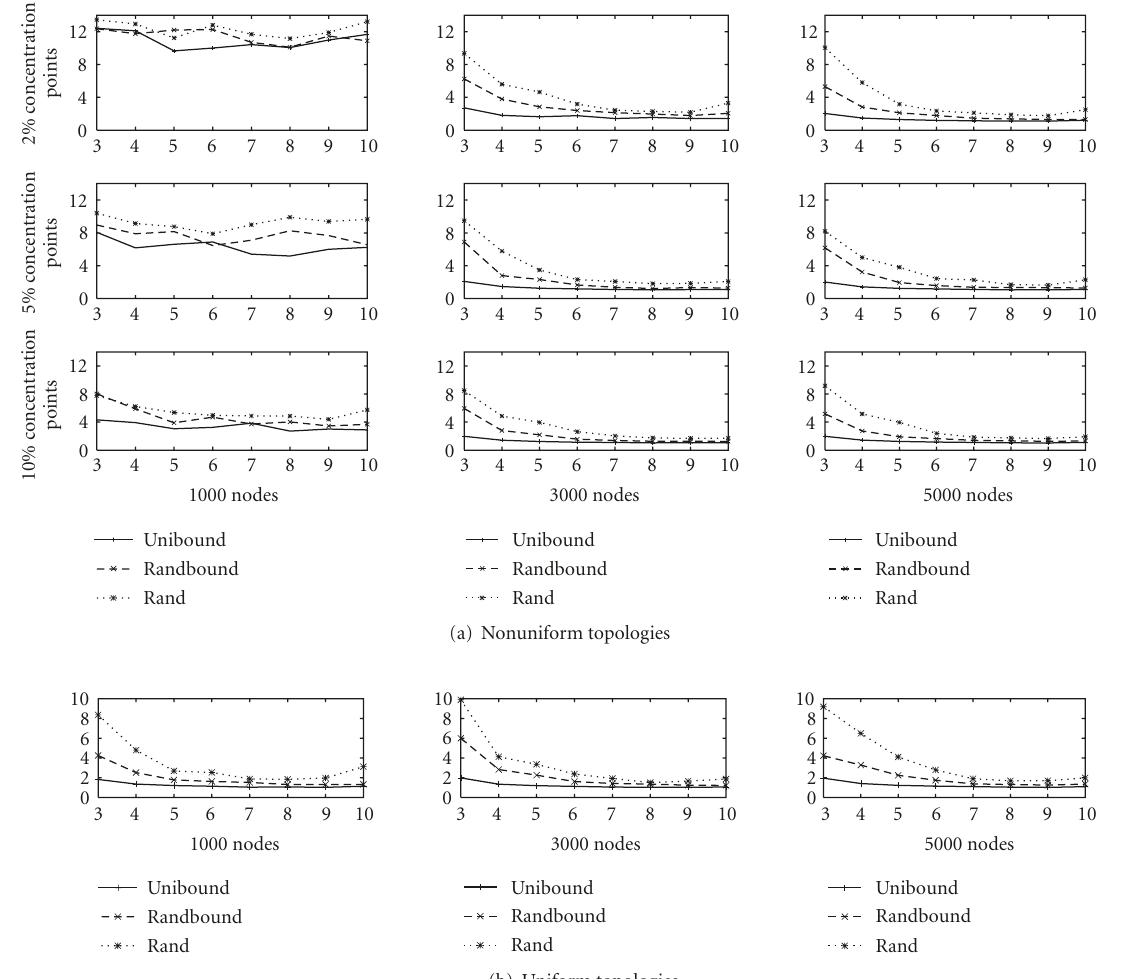
Figure 8: Maximum zone size ( y axis) in radio range units as a function of number of landmarks ( x axis) for di ff erent